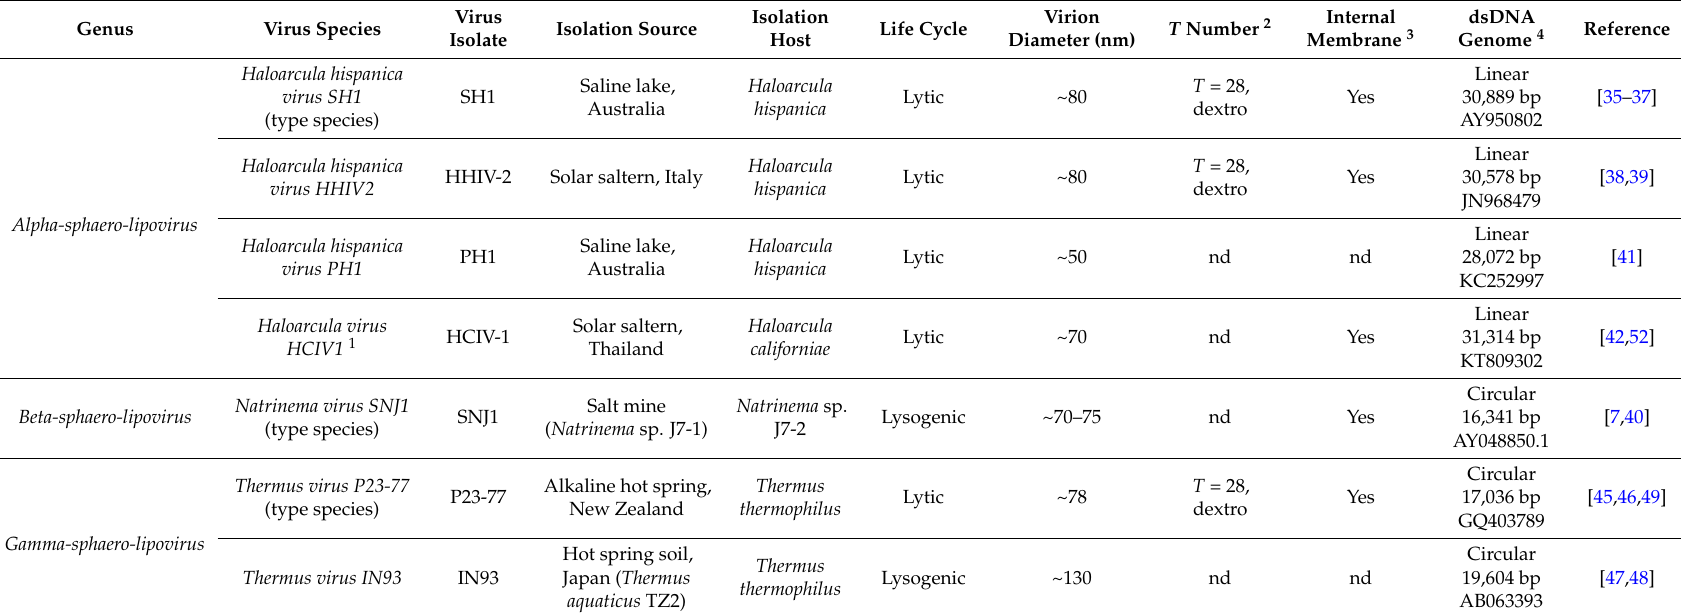
Table 1. Virus species belonging to the three genera of the family Sphaerolipoviridae